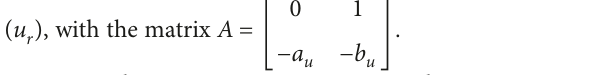
1 , (b) phase portrait, (c) desired trajectory errors, and (d) signal